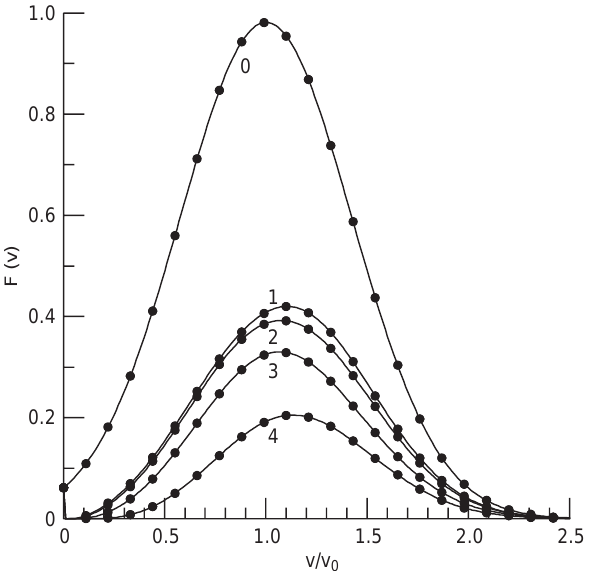
Fig. 1. The transformation of energetic electrons distribution over energy F (cid:133) v (cid:134) with increase in u in the strong di(cid:128)usion case at equatorial plane.